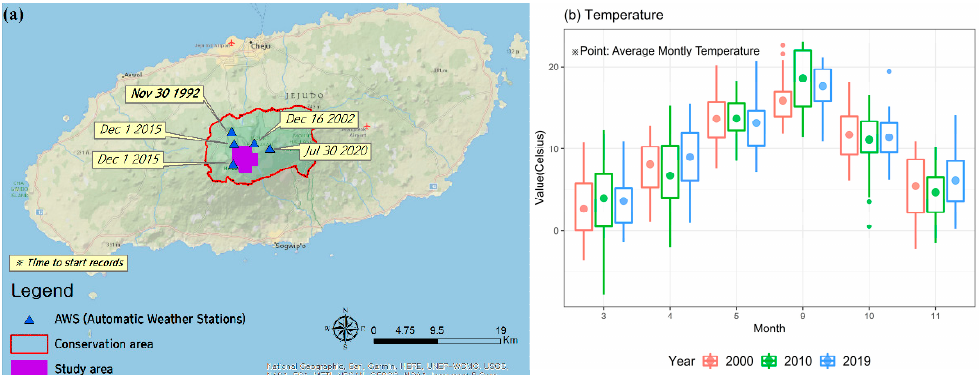
Figure 6. ( a ) Locations of automatic weather stations in study area, ( b ) time-series graph of monthly average temperature data (data source: Korea Meteorological Administration).